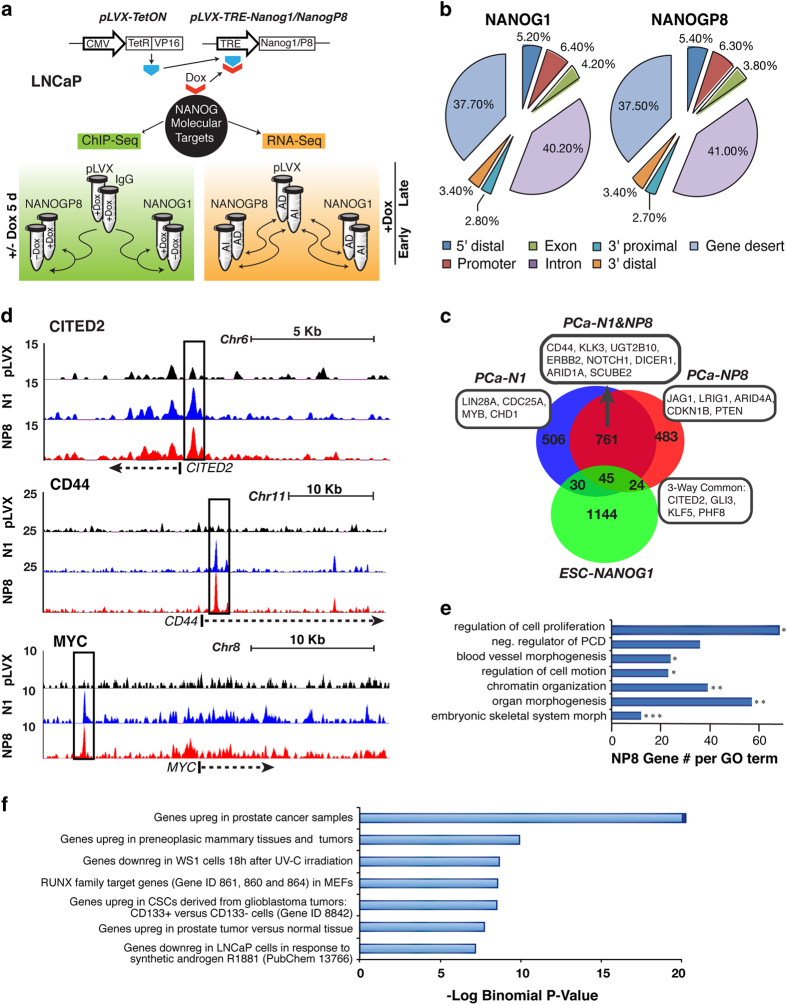
Distinct genomic occupancy of NANOG. (a) Scheme for ChIP-Seq and RNA-Seq in LNCaP cells expressing NANOG1 (N1) or NANOGP8 (NP8) vs vector control (pLVX) for the indicated time with or without DOX. (b) Genomic distribution of NANOG occupancy relative to the transcription start site (TSS) or transcription end site (TES) of the nearest gene. 5′ distal (−15 kb to −5 kb from the TSS), promoter (−5 kb to +0.5 kb from the TSS), 3′ proximal (−0.5 kb to +5 kb from TES), 3′ distal (+5 kb to +15 kb from the TES); gene desert is all other genomic regions. (c) Venn diagram of the promoter region (−8 kb to +2 kb) occupancy of NANOG in ESCs [16] vs N1 and NP8 in LNCaP cells. (d) Representative ChIP-Seq traces recovered from the UCSC genome browser. (e) Promoter region (−8 kb to +2 kb) occupancy gene ontology (GO) analysis via DAVID. Presented are GO Term Biological Processes, level 4; *P<0.05; **P<0.01; ***P<0.001. (f) Distal occupancy GO analysis via GREAT. MSigDB correlations are shown and plotted according to the binomial raw P-value.